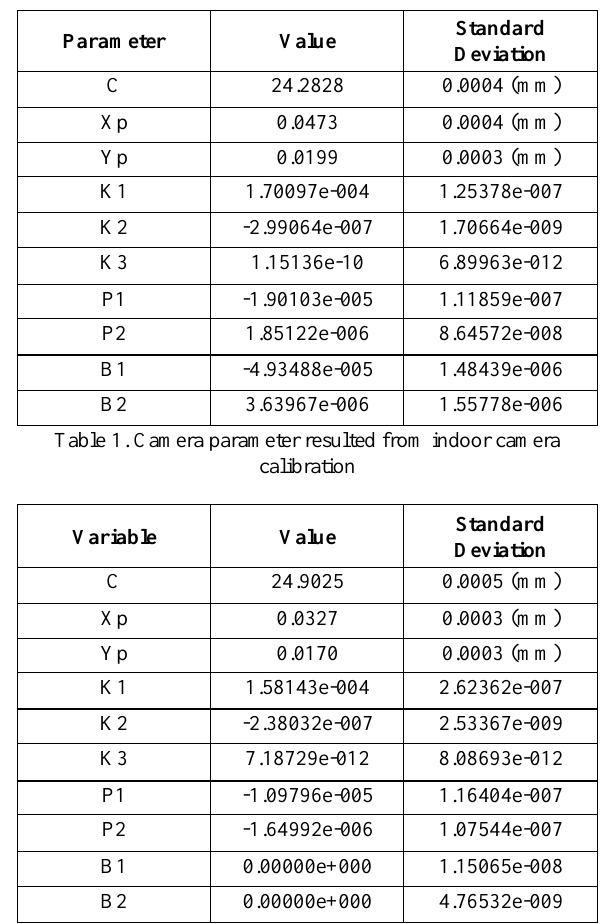
Table 2. Camera parameter resulted from outdoor camera calibration